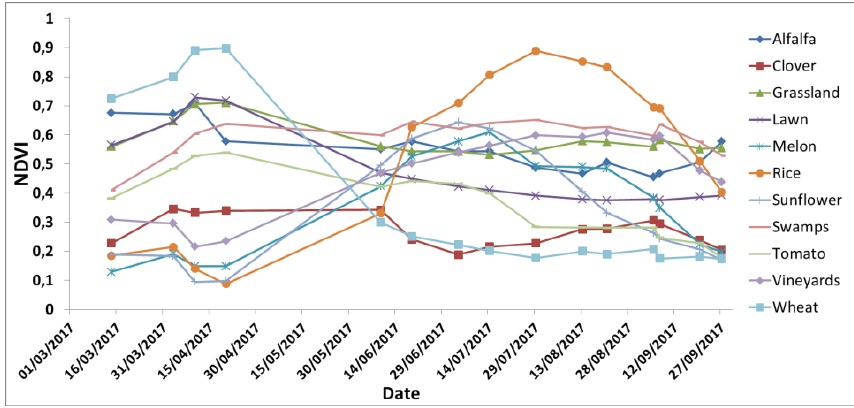
Figure 2: NDVI time series of 11 crop types in the study area Figure 2. NDVI time series of 11 crop types in the study